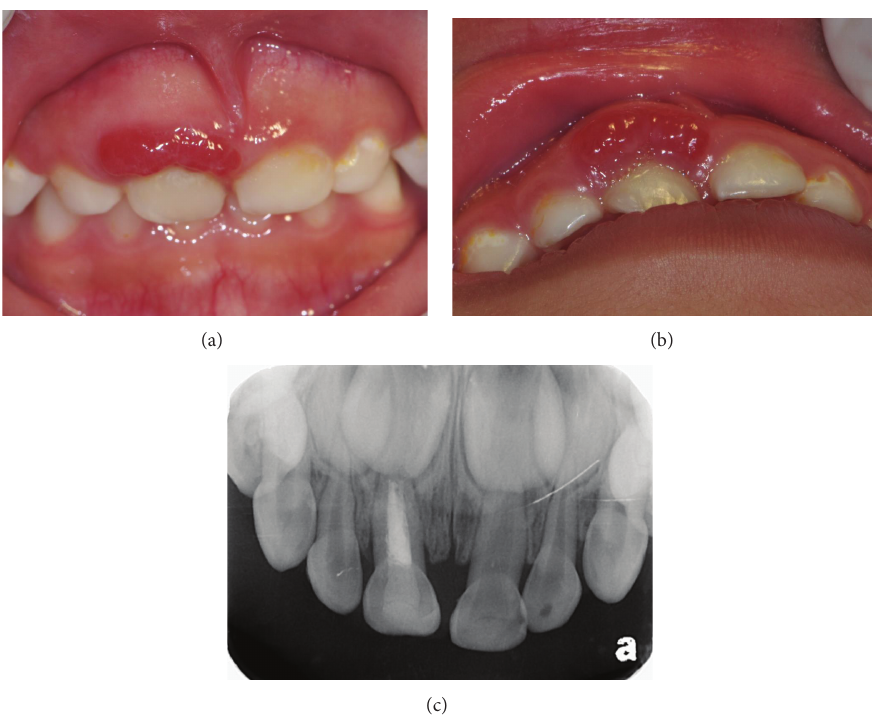
Figure 1: Clinical and radiographic appearances. (a) Frontal view: a fiery red gingival lesion on the labial side of the primary maxillary right central incisor. (b) Occlusal view: the maxillary right primary central incisor was a little palatally displaced. (c) A pulpectomy and restoration had been done for the primary maxillary right central incisor at a local dental clinic. There was no observable radiopaque abnormality in the periapical